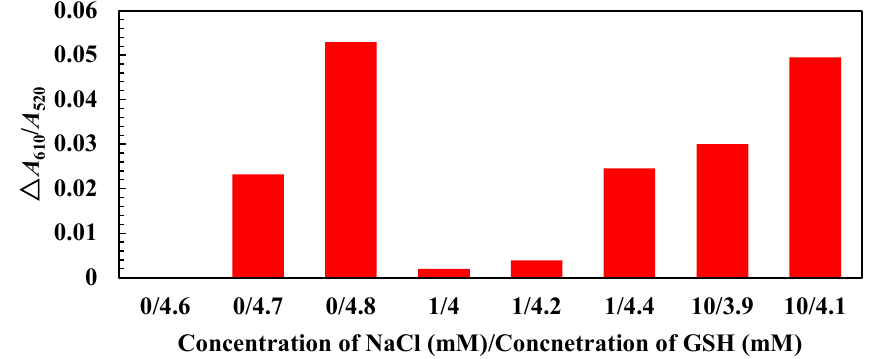
Figure 4. The effect of NaCl and GSH concentration on assay sensitivity ( Δ A 610 / A 520 ) (buffered by a pH 8 phosphate buffer